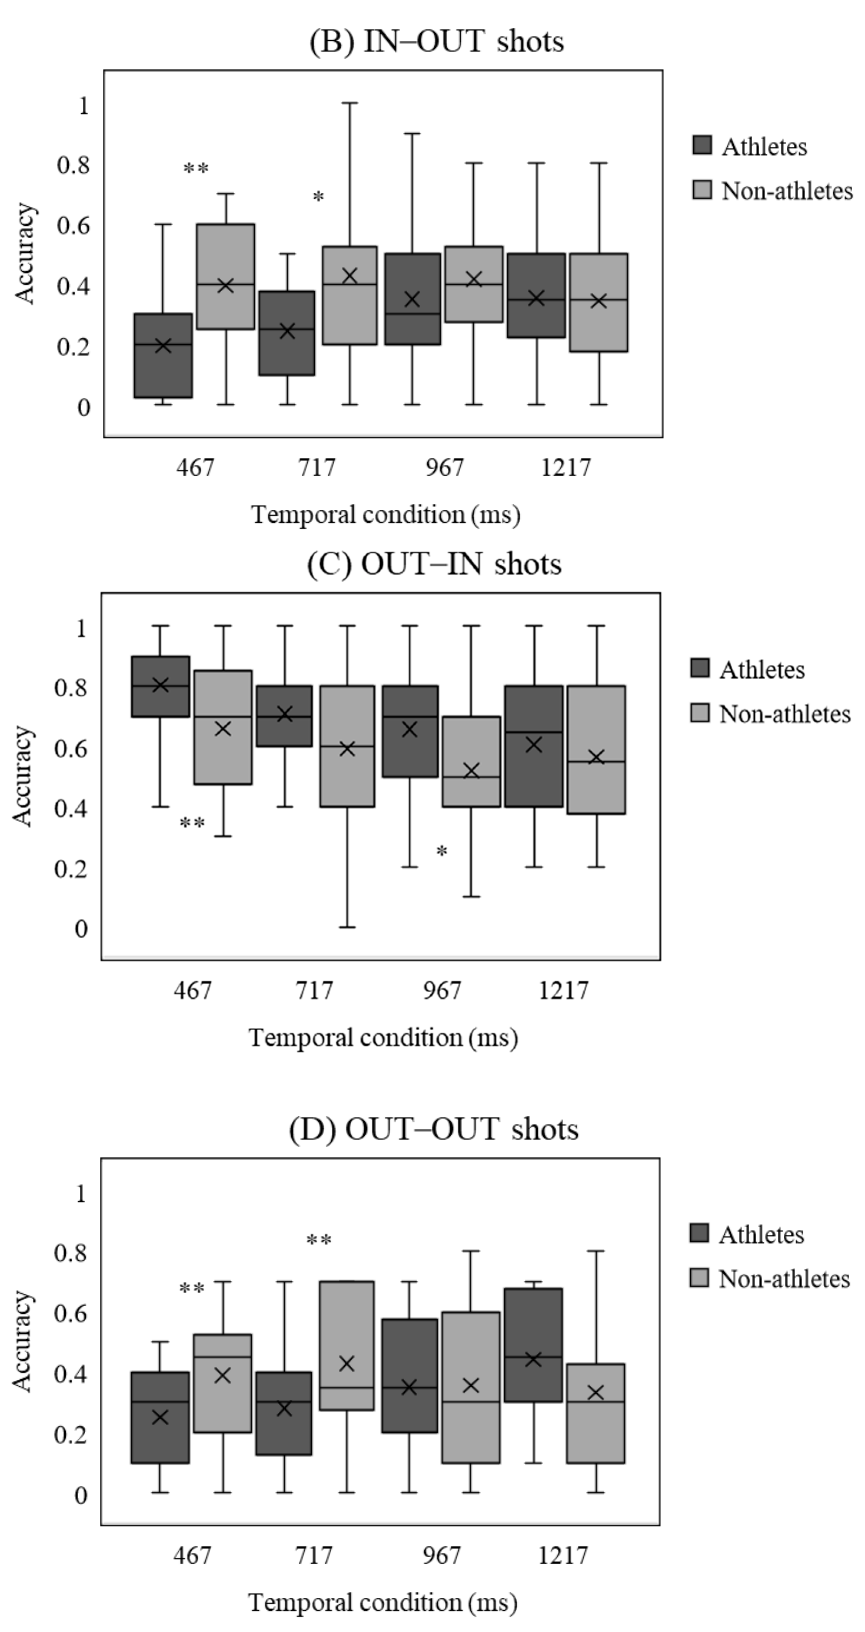
Figure 3. Mean accuracy of every body–ball cue for athletes and non-athletes under all temporal conditions. Bars indicate standard errors. ∗ p < 0.05, ∗∗ p < 0.01.